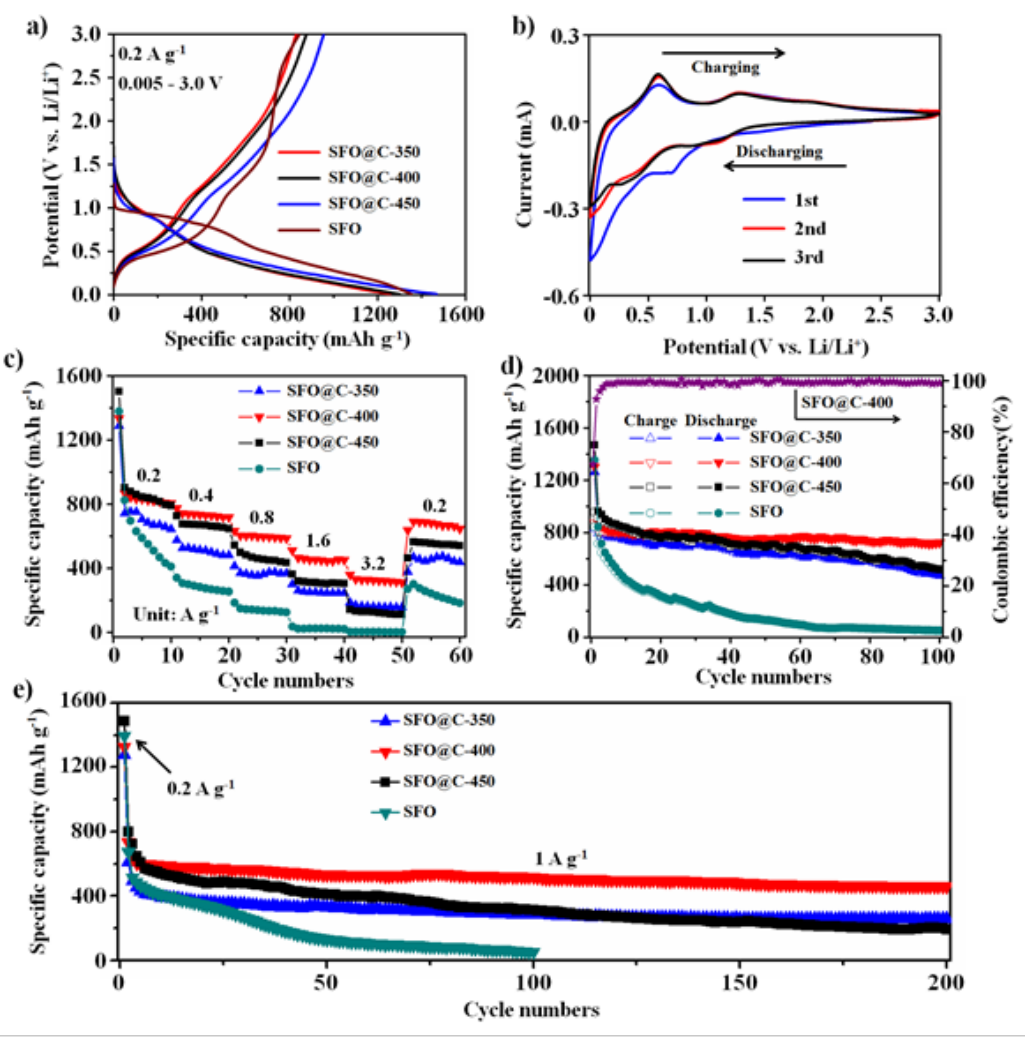
Figure 4. Electrochemical properties: ( a ) initial discharge / charge curves scanned at 0.2 A g − 1 ; ( b ) CV curves of SFO@C-400 at 0.1 mV s − 1 ; ( c ) rate capability at various current densities from 0.2 to 3.2 A g − 1 ; ( d ) cycling stability of 100 cycles at 0.2 A g − 1 ; ( e ) long-term cyclic life up to 200 cycles at 1 A g − 1 .